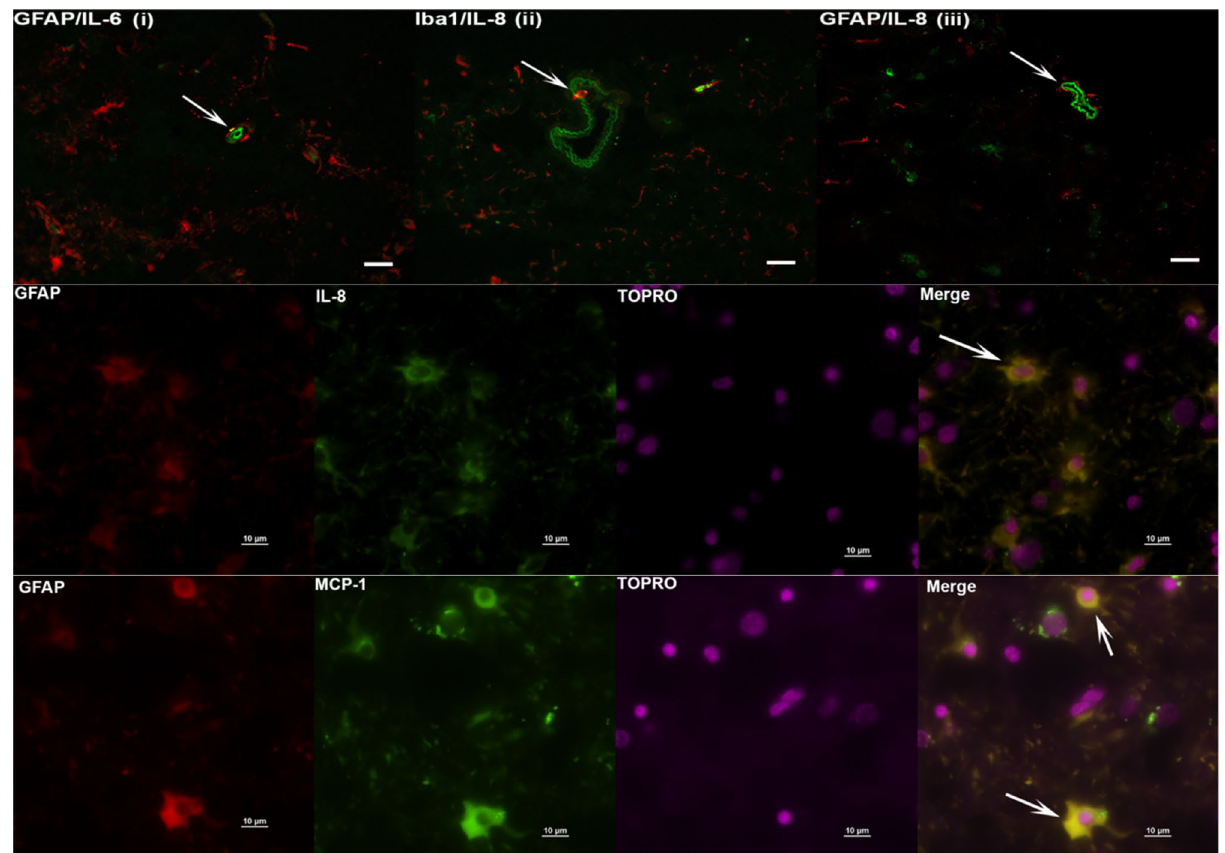
Figure 3. Immunohistochemical staining for inflammatory mediators and brain cells. Tissue sections from Frontal cortex were stained for IL-6, IL-8 and MCP-1, along with cell type specific markers. Top panel ( i – iii ) shows IL-6/ IL-8 (green) staining likely within endothelial cells. GFAP or Iba1 are stained in red. Bar represents 25 µm. IL-6 staining in GFAP + astrocytes ( i ), IL-8 staining in Iba1 + microglia ( ii ) are also seen, as yellow colocalization (arrows). In top panel ( iii ) the arrow points to IL-8 staining (green) in likely endothelial cells. Middle Panel shows IL-8 (green) stain in GFAP positive (red) cells co-localizing as yellow. The bottom panel similarly shows MCP-1 staining (green) in astrocytes stained with GFAP (red), resulting in yellow colocalization. Top panel is from Animal 1, middle panel from Animal 2 and bottom panel from Animal